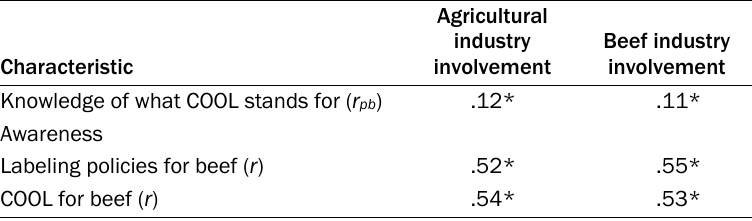
Table 3. Relationships Between Industry Involvement